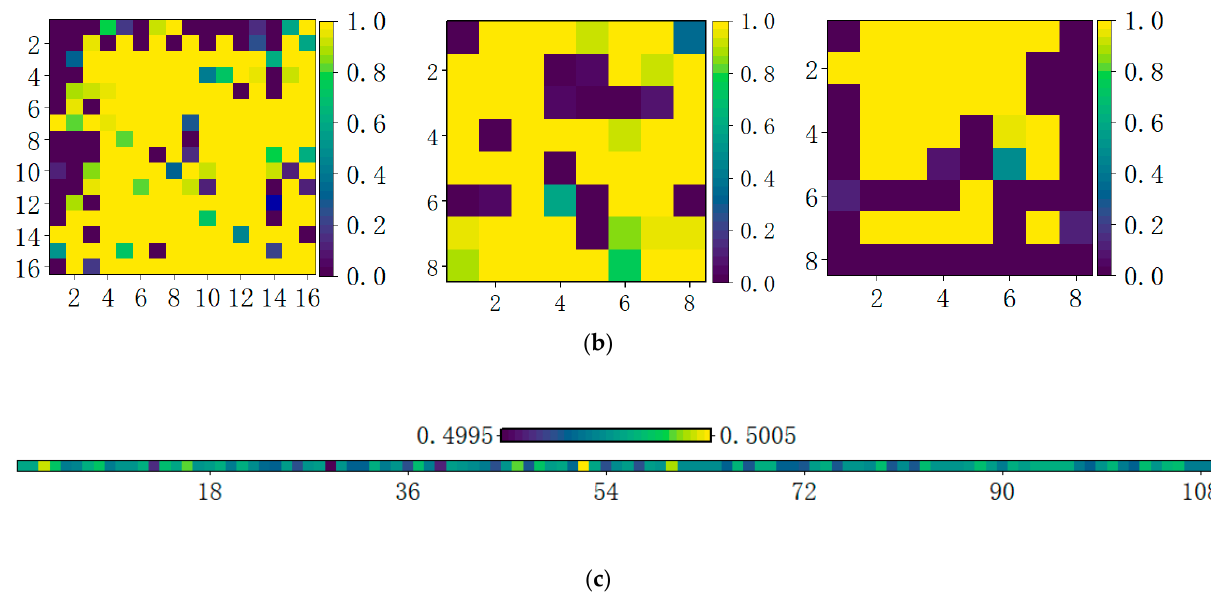
Figure 13. Attention visualization. ( a ) CNN branching channel attention visualization; ( b ) CNN branching position attention visualization; ( c ) GRU branch attention visualization.